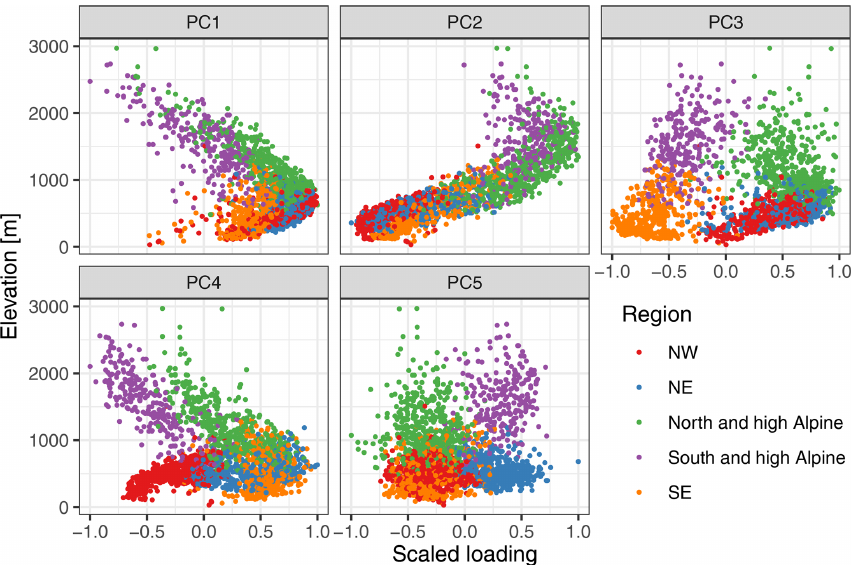
Figure 4. Scatterplots of principal component (PC) loading vs. elevation and region. The PC loading can be considered the correlation of the original series with the respective PC. See Fig. 3 for a map of the PC loadings and Fig. 5 for a map of the